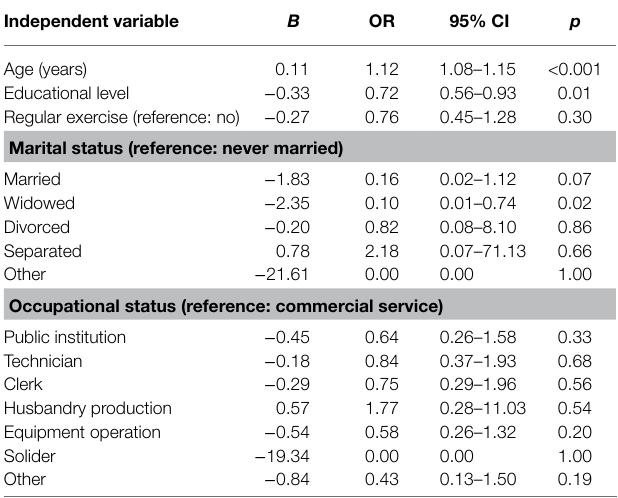
TABLE 3 | Binary logistic regression of the association between cognitive impairment and